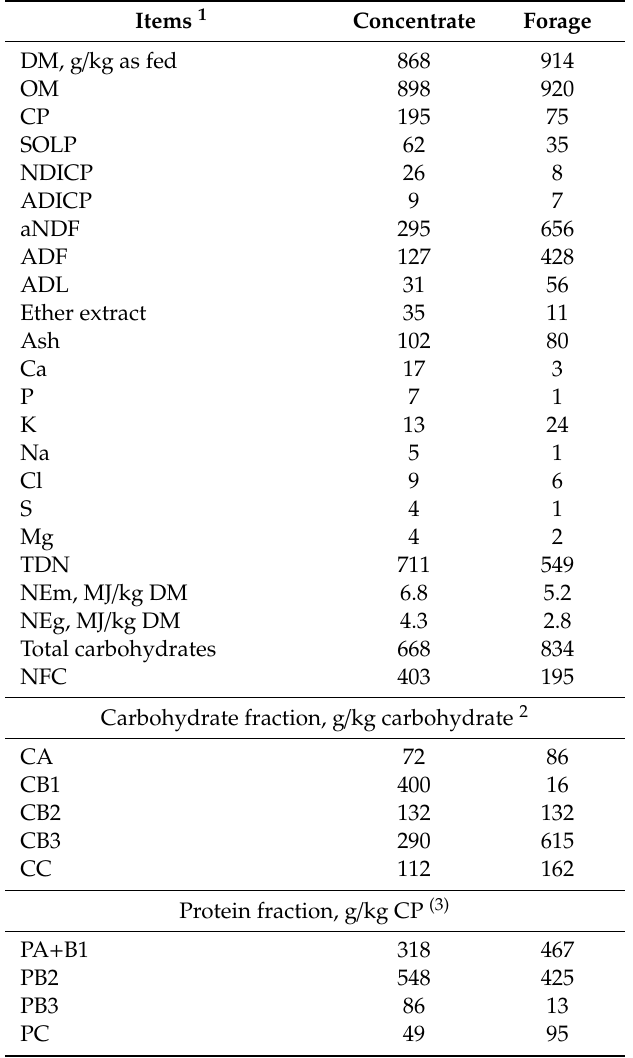
Table 1. Analyzed chemical composition (g / kg DM or as stated) of the experimental diets. Items 1